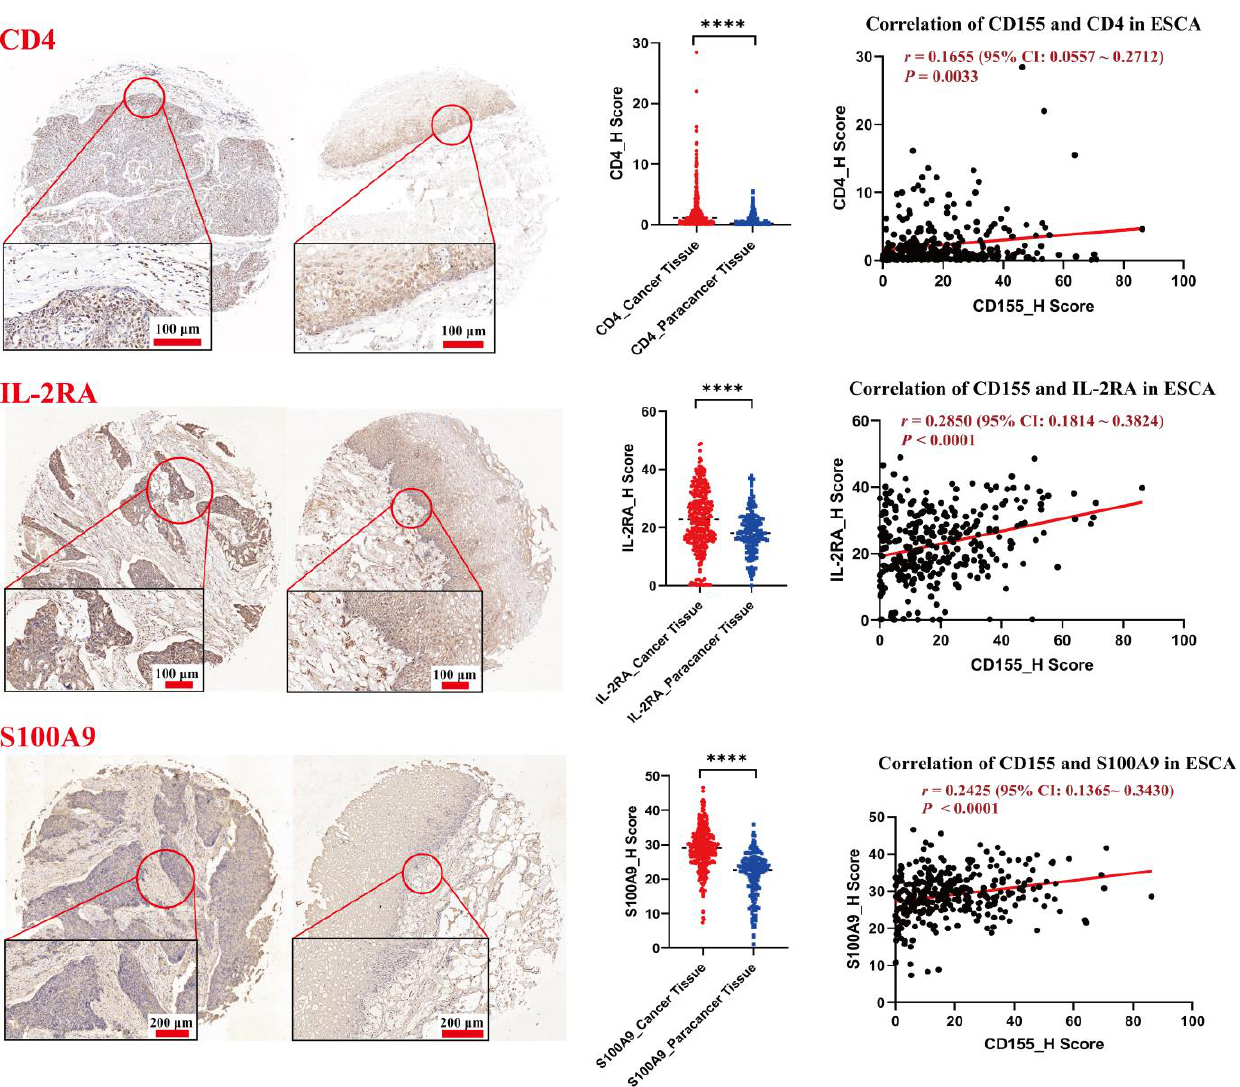
Figure 4. CD155 is positively associated with the expression of CD4, IL-2RA, and S100A9. Three immune-related markers were stained by performing immunohistochemistry. A correlation analysis between CD155 and immune markers was performed, and positive correlations were observed between CD155 and CD4 ( r = 0.1655, p = 0.0033), IL-2RA ( r = 0.2850, p < 0.0001), and S100A9 ( r = 0.2425, p < 0.0001). **** p < 0.0001.